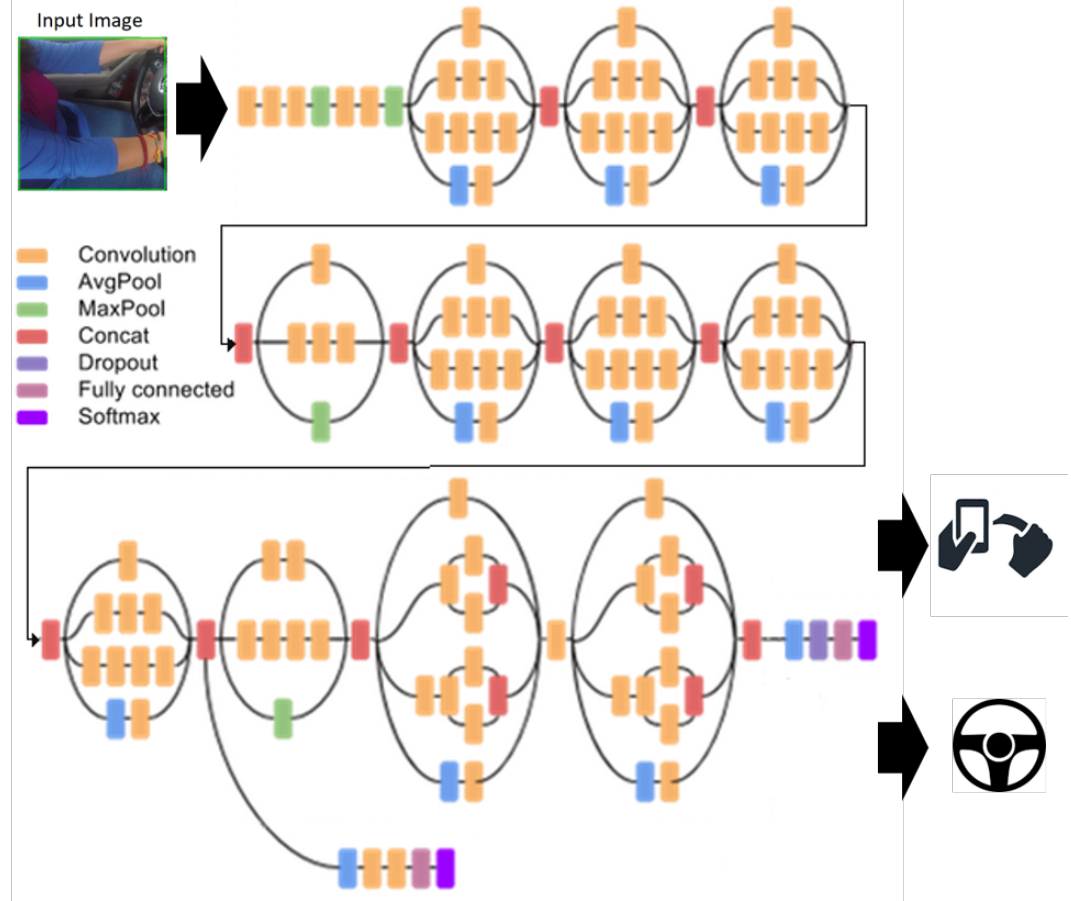
Figure 3. Inception V3 CNN architecture. Adapted from